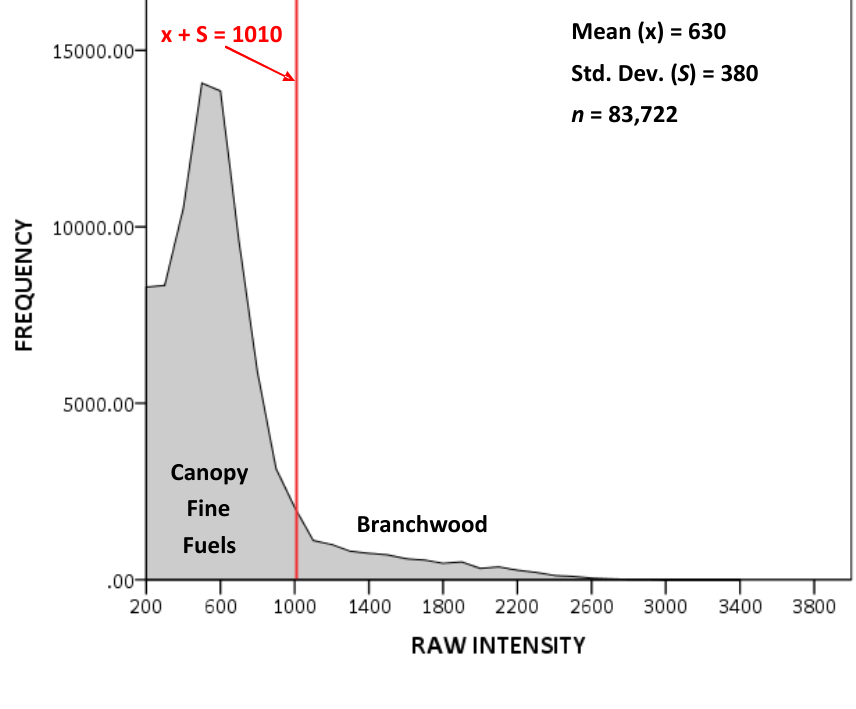
Figure 10. Histogram for all whole-branch Douglas-fir scans at 25 m and 0°, illustrating the canopy fine fuel intensity threshold equal to mean plus one standard deviation (red line). x + S =